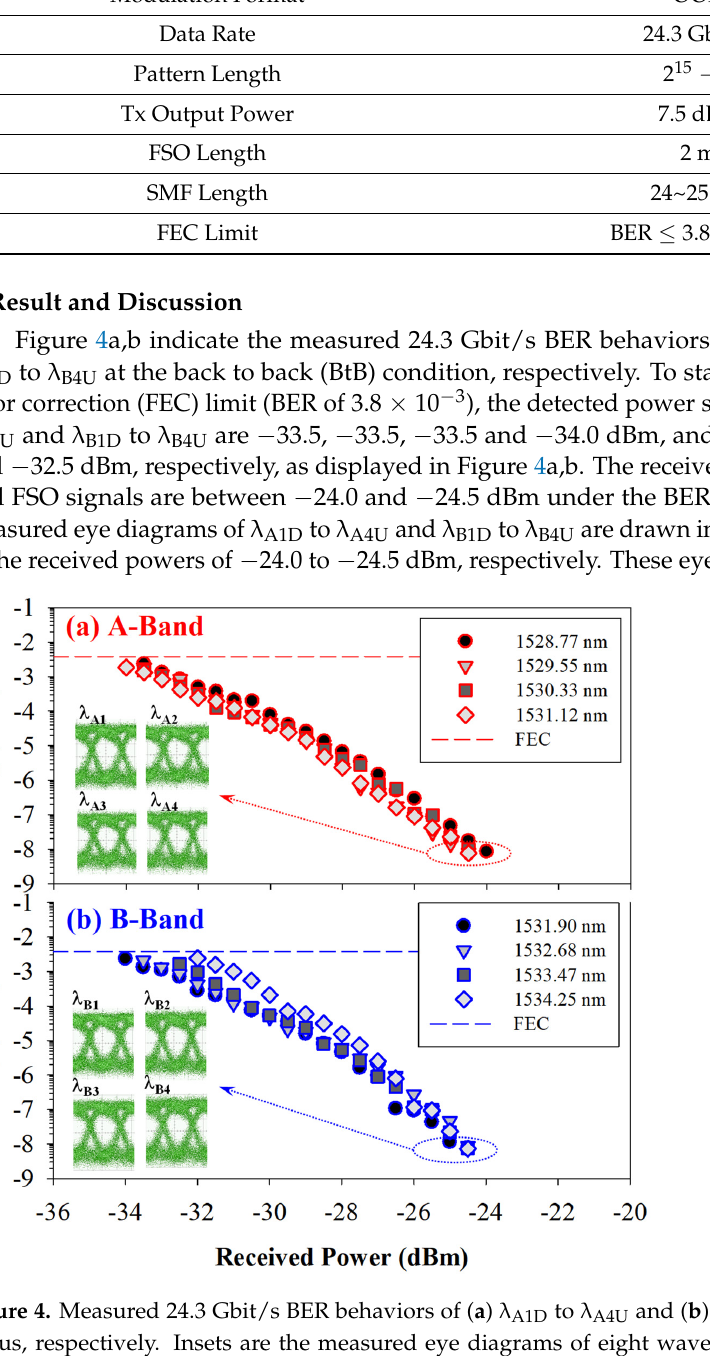
Table 1. Corresponding parameters of experimental setup.